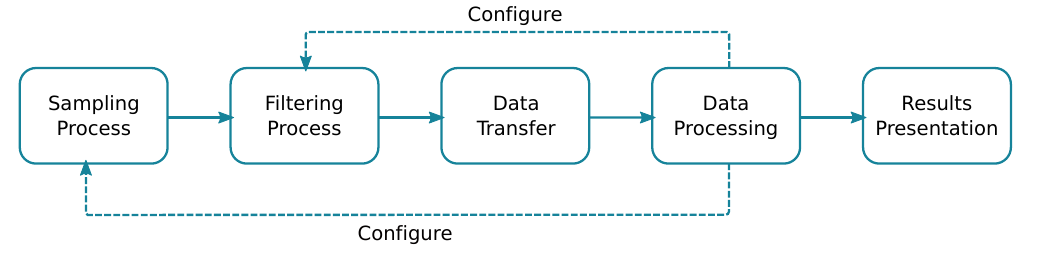
Figure 9. Crowdsensing